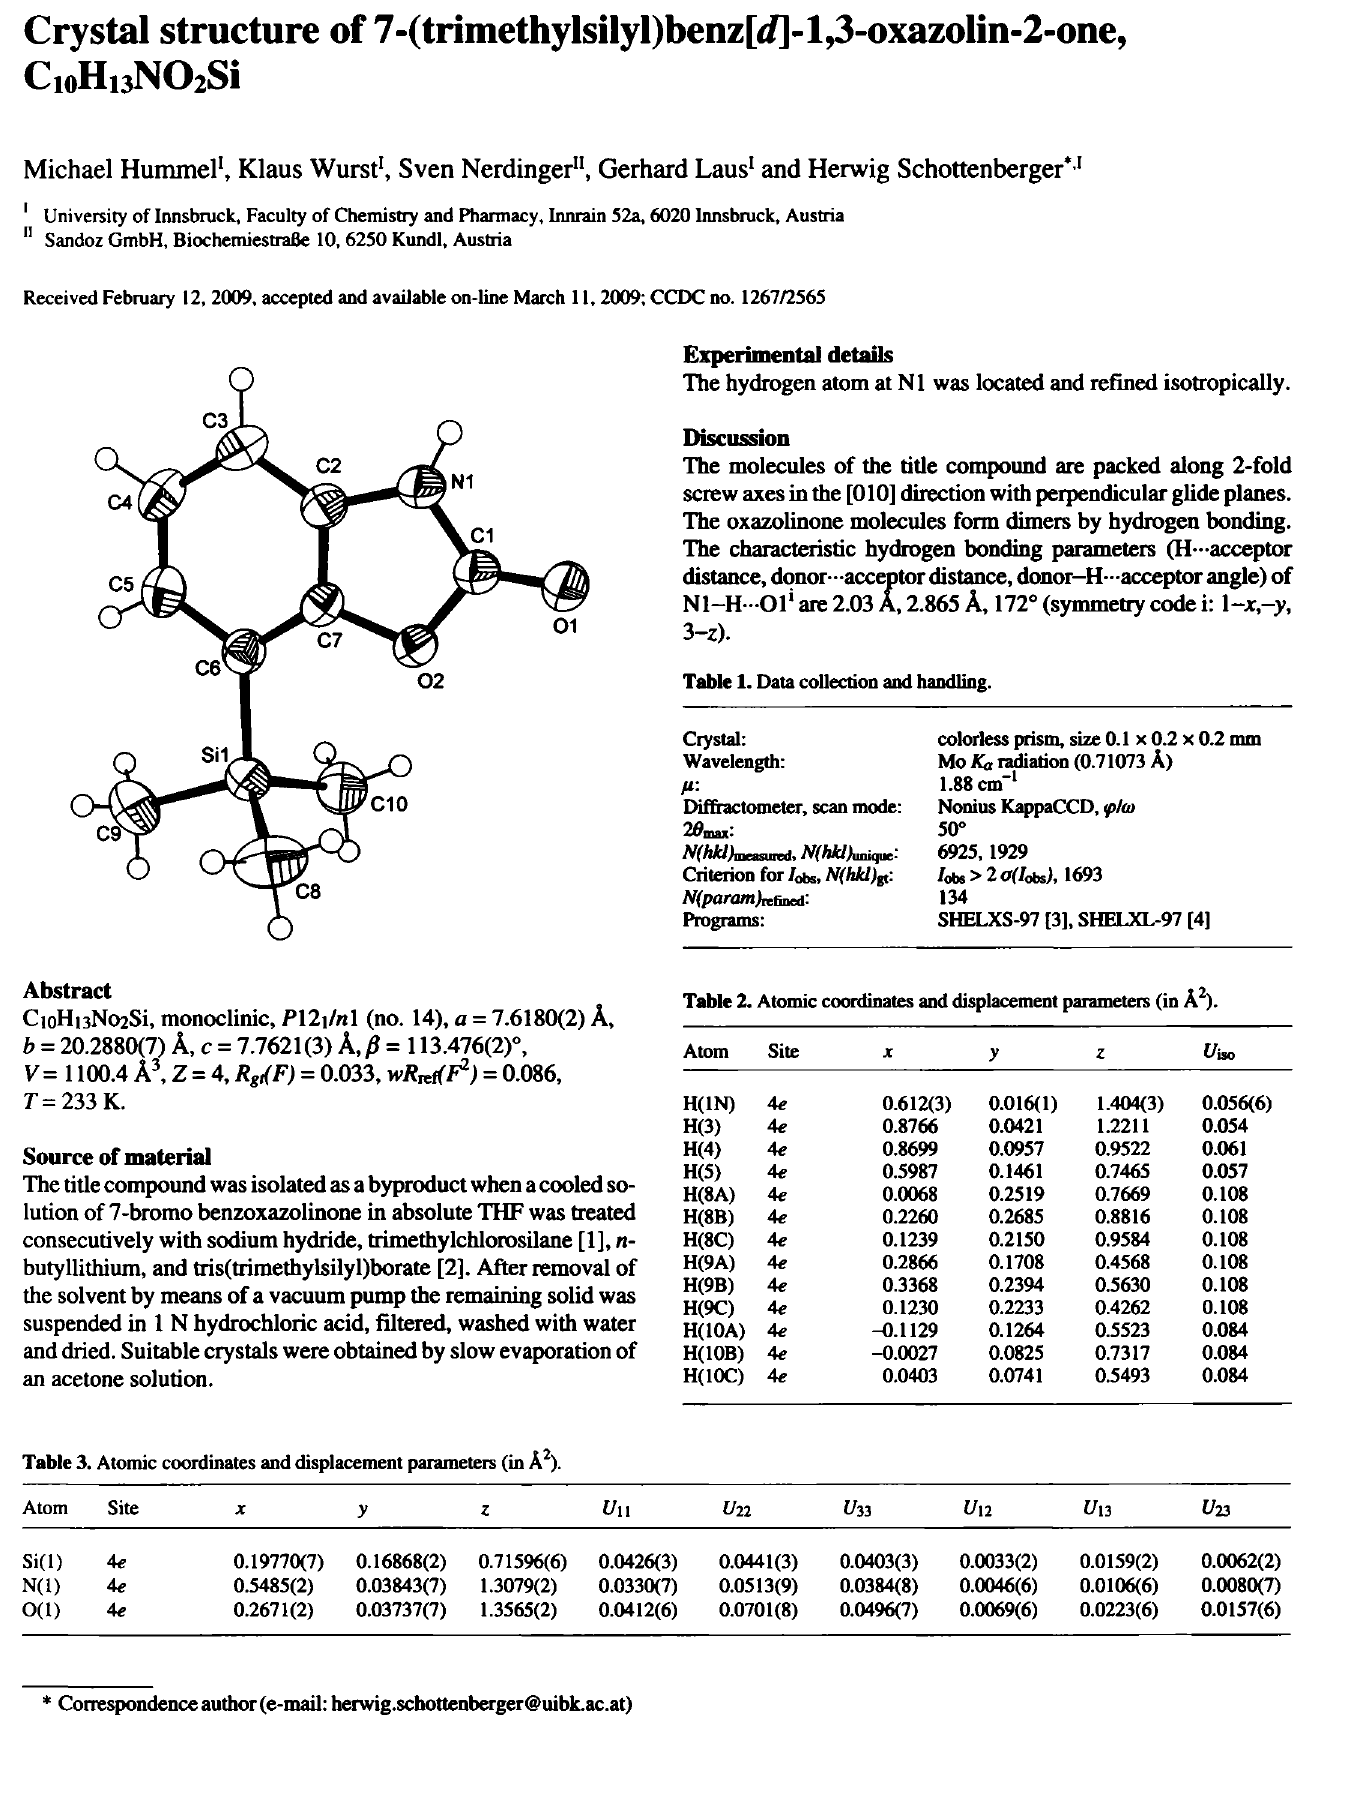
Table 3. Atomic coordinates and displacement parameters (in Â 2